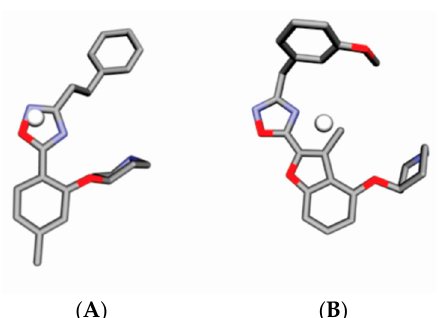
Figure 3. ( A ) Representation of compound 42 and GCOD-1 (0, − 3, − 1, hba) (white sphere), and ( B ) compound 81 . GCODs occupancy represented by white spheres contributes to increasing the potency of compounds. The gray and red representations are carbons and oxygen atoms.